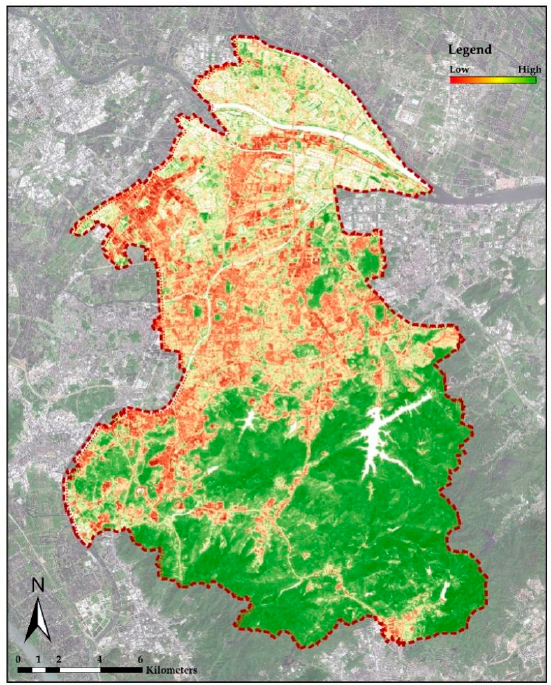
Figure 10. The overall greening quality of the study area.